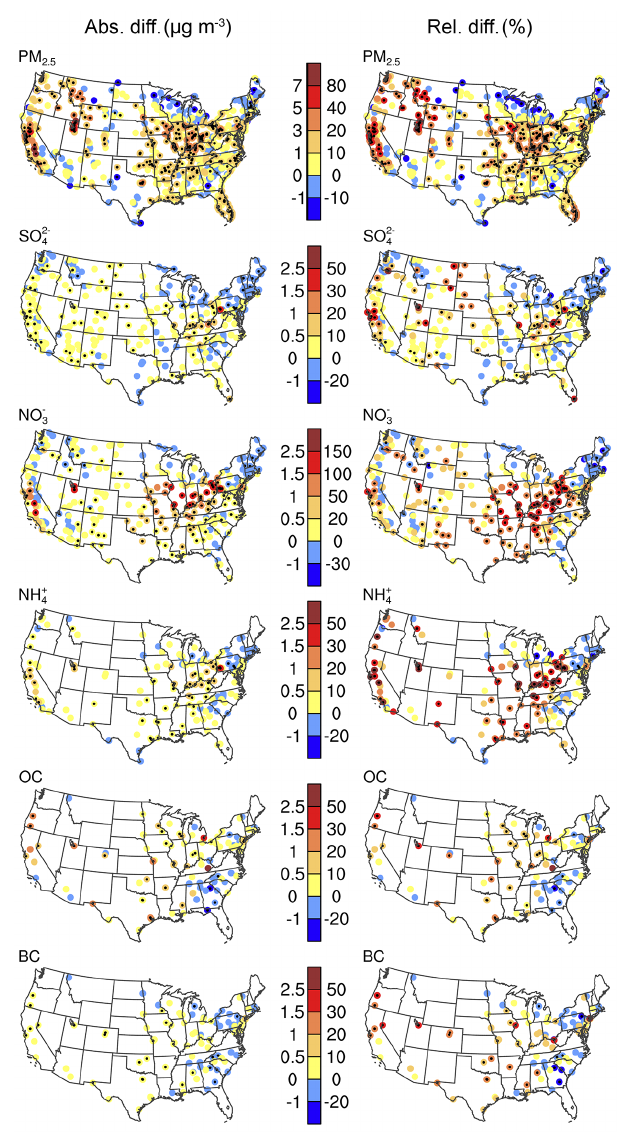
Figure 3. The absolute (µgm − 3 , left column) and relative differ- ences (%, right column) in observed monthly mean aerosol concen- trations between PNA + and PNA − months (PNA + minus PNA − ). See Fig. 2c for the definitions of PNA + and PNA − months. The measurements of PM 2 . 5 were carried out over 1999–2013, in which there were 18 PNA + months and 18 PNA − months as shown in Fig. 2a. The measurements of speciated aerosols were taken during 2000–2013, in which there were 17 PNA + and 17 PNA − months (Fig. 2b). The seasonal cycle and trend in observed aerosol con- centrations were removed as described in Sect. 2.1. The sites with black dots were the differences that passed the two-tail t test with 90% confidence